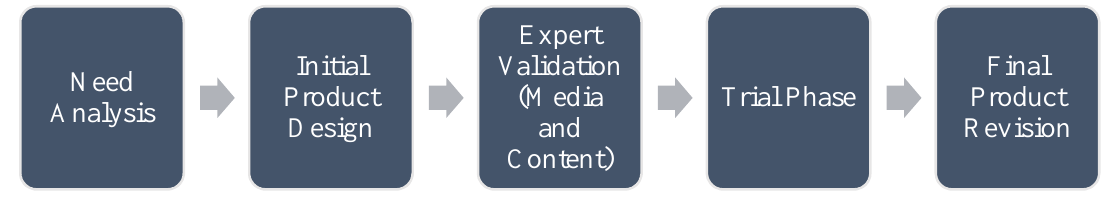
Figure 1. The flow chart of research procedure (adapted from Dick, Carey, Carey, 2015)